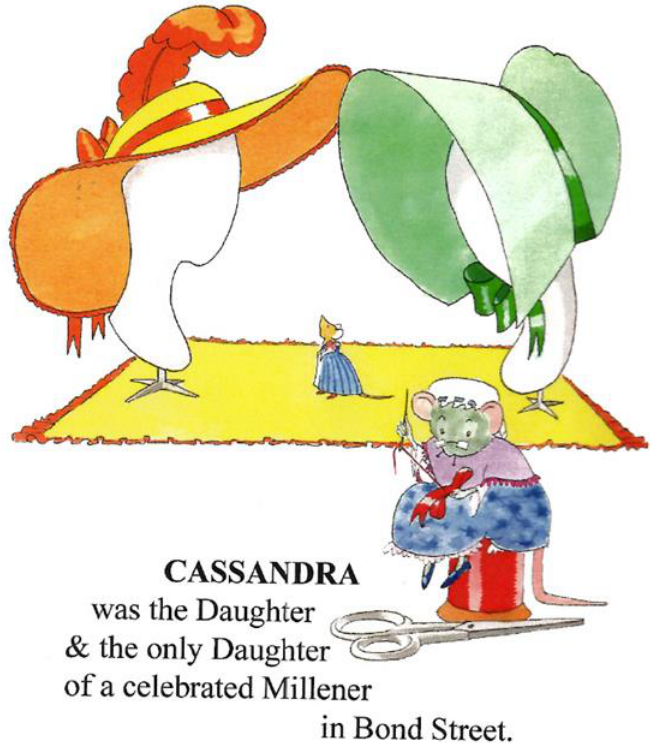
Figure 2. Juliet McMaster’s illustration for The Beautifull Cassandra (Austen 2021), p. 1. Reproduced with permission by Juvenilia Press.